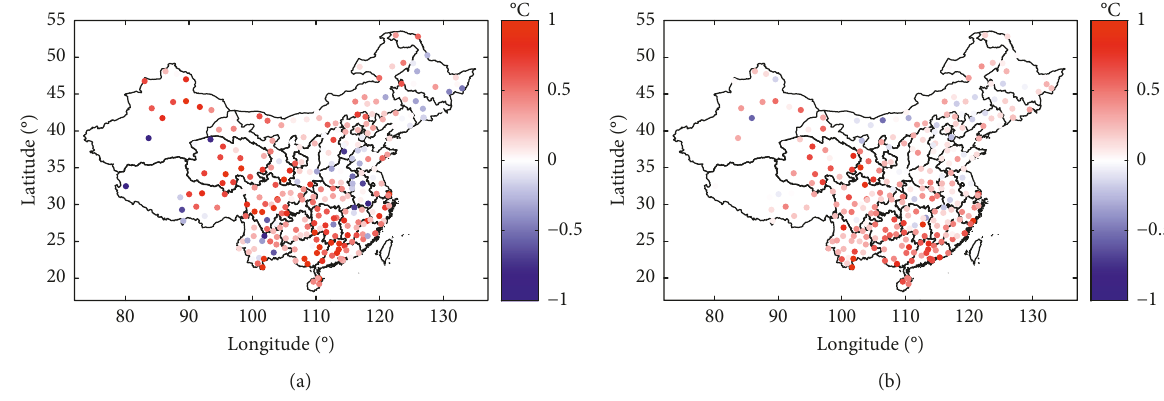
Figure 6: Spatial distribution of the RMSE difference caused by RH errors for linear (a) and NN (b)